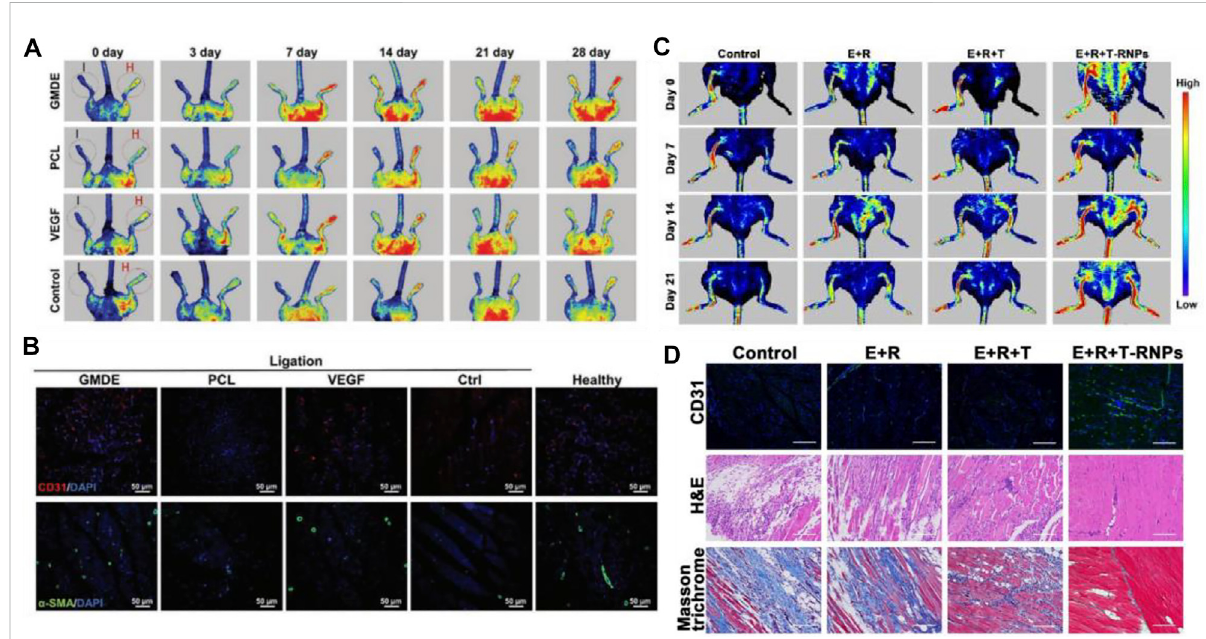
FIGURE 11 Schematicdiagramsofscaffoldstoimprovebloodperfusion. (A) LDPIimagesofischemichindlimbsshowedthatGMDEscaffoldgrouphadthe best angiogenic effect. (B) Immuno fl uorescent staining for CD31 and α -SMA of thigh muscle showed that GMDE scaffold could promote angiogenesis.Scalebar=50 µm. (C) LDPIimagesofischemichindlimbsshowedthatT-RNPs-anchoringhydrogelscaffoldloadedwithEPCshadthe best angiogenic effect. (D) Immuno fl uorescent images of CD31, H&E, and Masson ’ s trichrome staining of ischemic muscles. The E + R + T-RNPs group had highest blood vessel density and lowest levels of in fl ammation and fi brosis. Scale bar = 200 μ m. (A,B) are reprinted with permission from ref. (Mu et al., 2021). (C,D) are reprinted with permission from ref. (Li et al.,